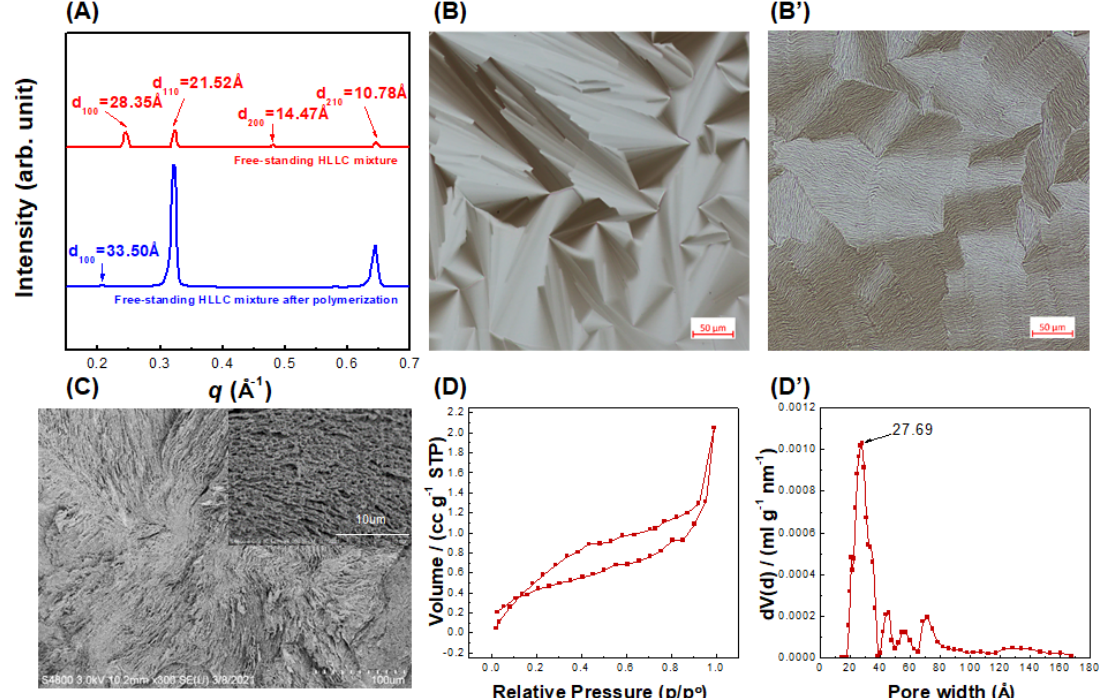
Figure 2. High-fidelity retention of the nanostructure of free-standing HLLC mixture and its characterizations. ( A ) XRD profiles before and after polymerization, polarized optical micrographs ( B ) before and ( B’ ) after polymerization, ( C ) scanning electron micrographs after polymerization, ( D ) N 2 adsorption and desorption isotherms, and ( D’ ) pore size distribution curve after polymeriza- tion.